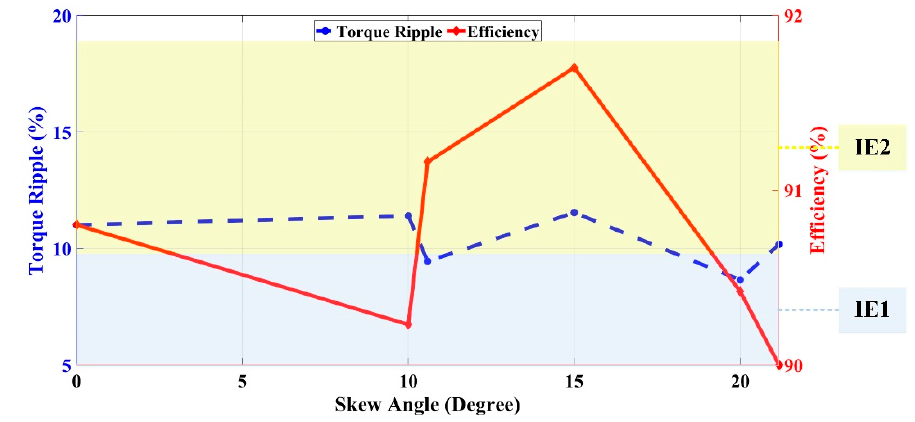
Figure 9. Efficiency and torque results of AFIM with 34 slots.